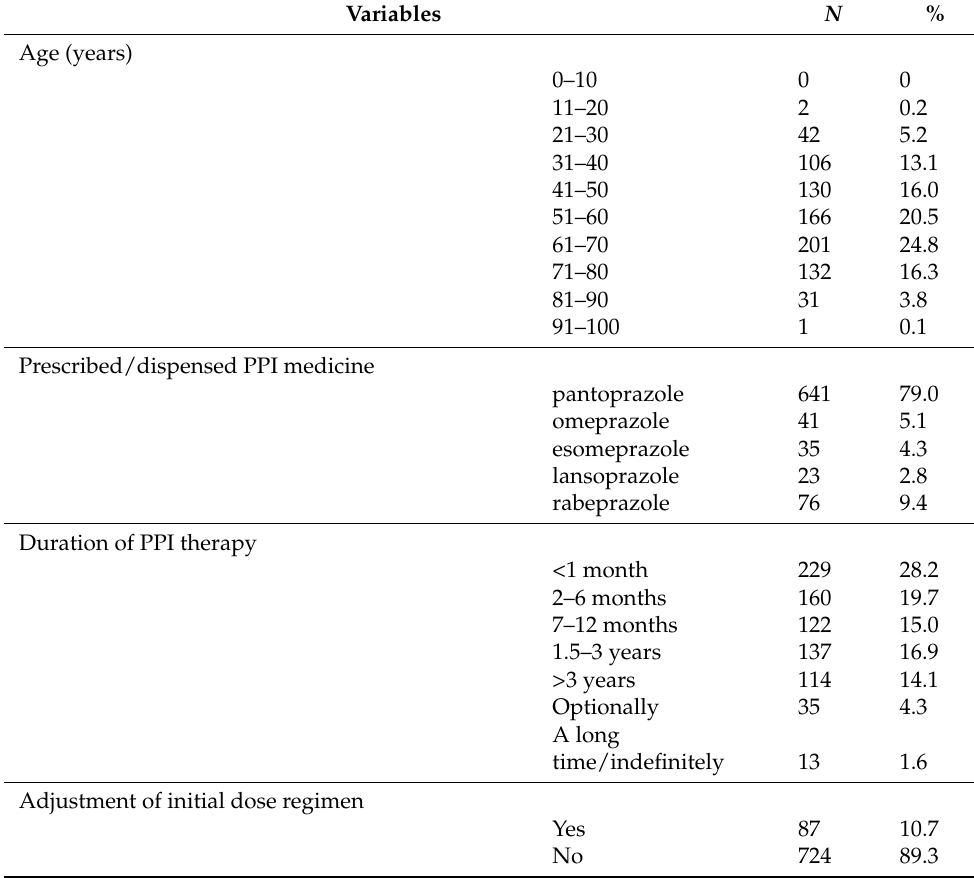
Table 6. Patients’ socio-demographic and PPIs utilisation characteristics, N =